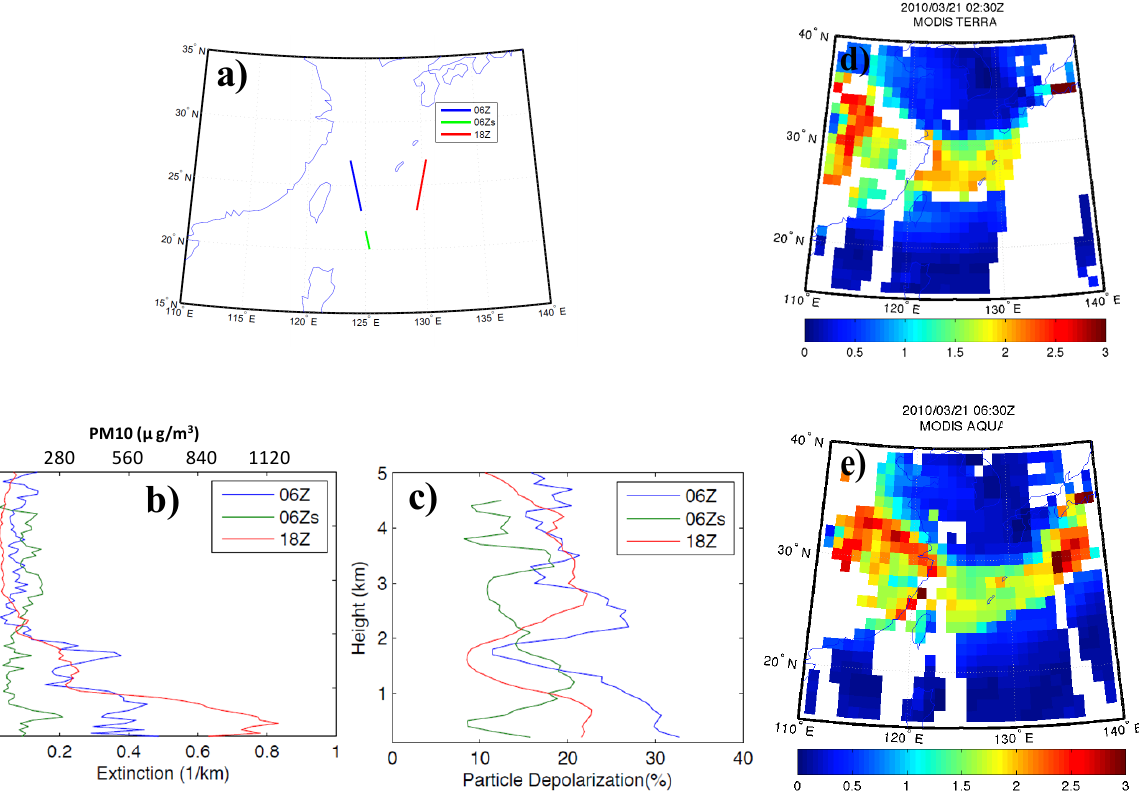
Fig. 6. (a) The CALIPSO orbit tracks around Taiwan at 06:00UTC (blue and green), and 18:00UTC (red), 21 March 2010. (b) The vertical distribution of extinction coefficient and PM 10 concentration deduced from CALIPSO Lidar at orbit tracks in (a) around Taiwan. (c) The vertical distribution of the percentage of depolarization ratio from CALIPSO Lidar at orbit tracks in (a) around Taiwan. (d) The aerosol optical depth (AOD) deduced from the MODIS satellite at 02:30UTC, 21 March 2010. (e) Same as (d) but for at 06:30UTC.